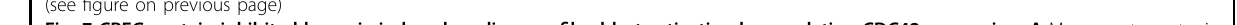
Fig. 7 CREG protein inhibited hypoxia-induced cardiac myo fi broblast activation by regulating CDC42 expression. A Mass spectrometry in the myocardium of CREG + / − mice and littermate control mice ( N = 3 per group). B , C Western blotting of CDC42, Rac1, and RhoA expression in the myocardium of CREG + / − mice ( N = 5 per group). D , E The effects of CREG recombinant protein (rCREG) and CDC42 overexpressed-adenovirus (adCDC42) on the expression of α SMA and collagen-1 induced by hypoxia as determined by western blotting ( N = 5 per group). F , G The effects of rCREG and adCDC42 on the expression of collagen-1 and PCNA induced by hypoxia as determined by immuno fl uorescence staining ( N = 3 per group). Green indicated collagen-1 expression, red indicated PCNA expression, and blue indicated nuclei. H CCK8 assays were used to evaluate the effects of rCREG and adCDC42 on cell proliferation ( N = 5 per group). I The effects of rCREG and adCDC42 on cell migration were determined by wound healing assays ( N = 3 per group). ** P < 0.01, * P < 0.05 vs. littermate control or control group; ## P < 0.01, # P < 0.05 vs. BSA + hypoxia group; & P < 0.05 vs. adGFP + hypoxia; $ P < 0.05 vs. adCDC42 + hypoxia